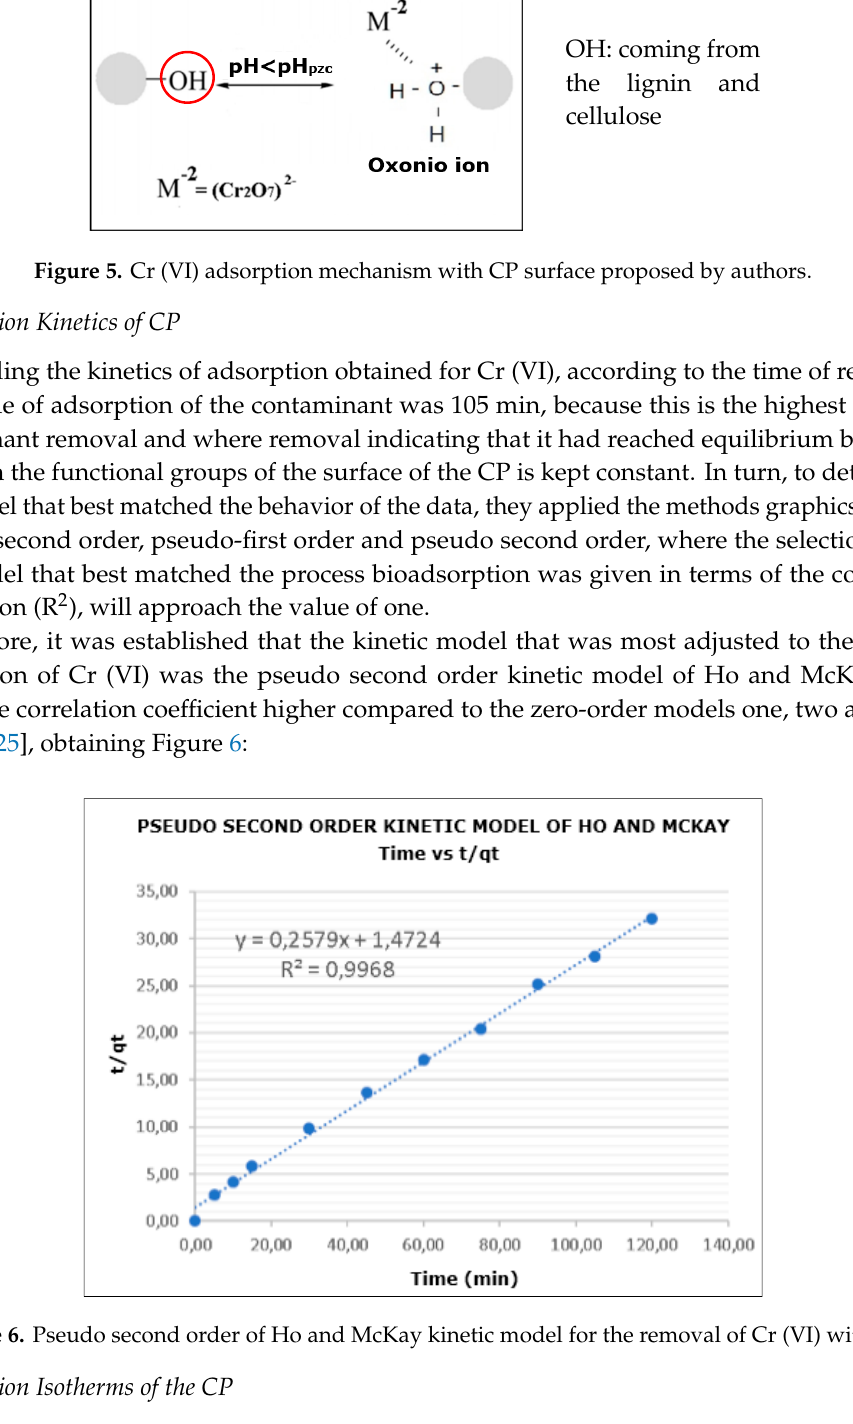
Table 3. Datos de isotermas de adsorción con CP.